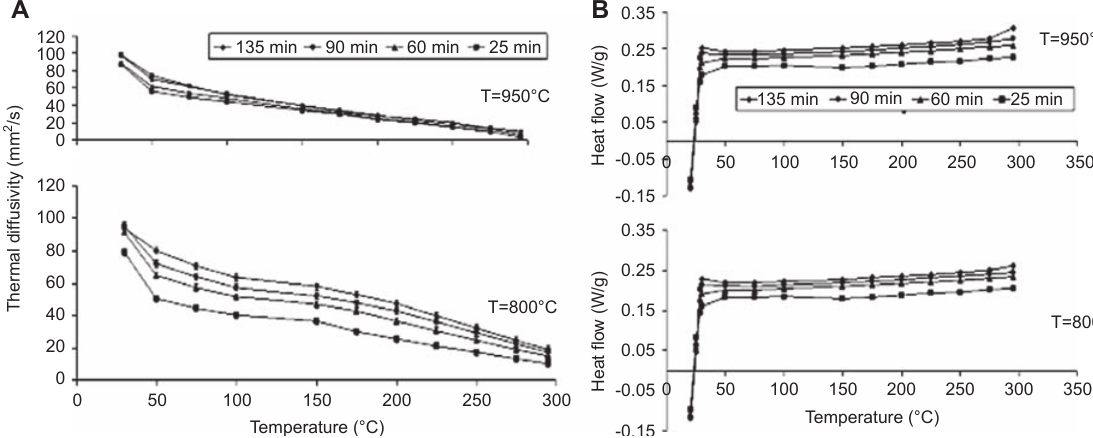
Figure 10 (A) Thermal diffusivity and (B) heat capacity of samples processed at 800 ° C and 950 ° C.